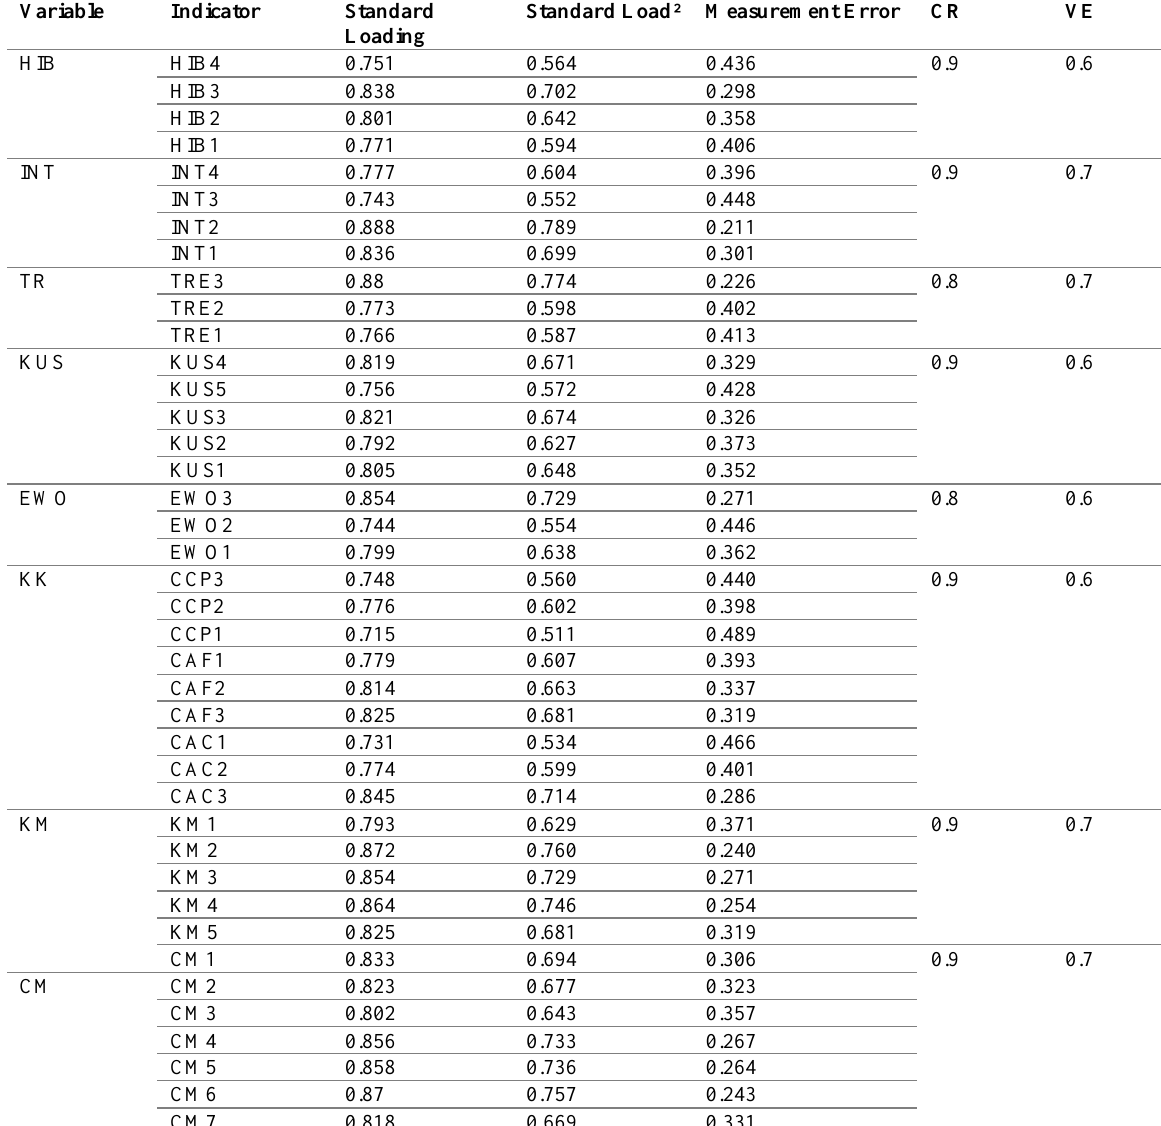
Table 1: Validity and Reliability